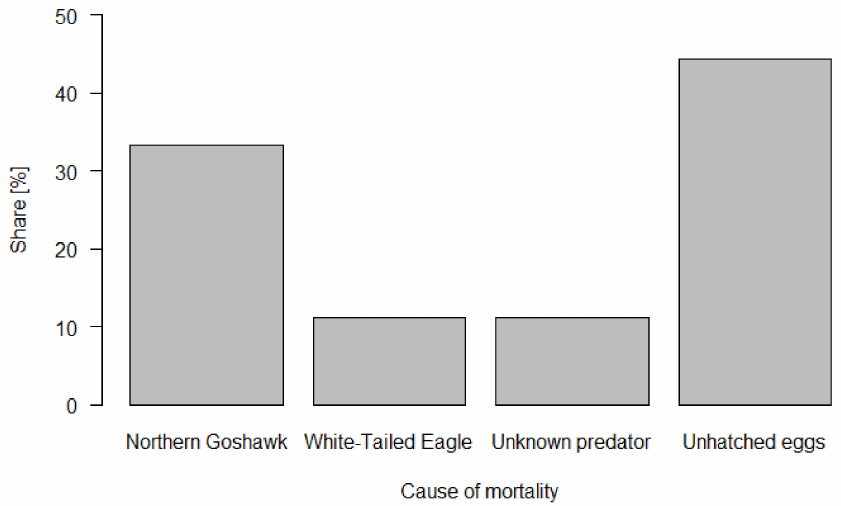
Figure 2. The share of causes of mortality of Osprey chicks in Poland determined on the basis of monitoring with the use of cameras ( n = 18—number of dead